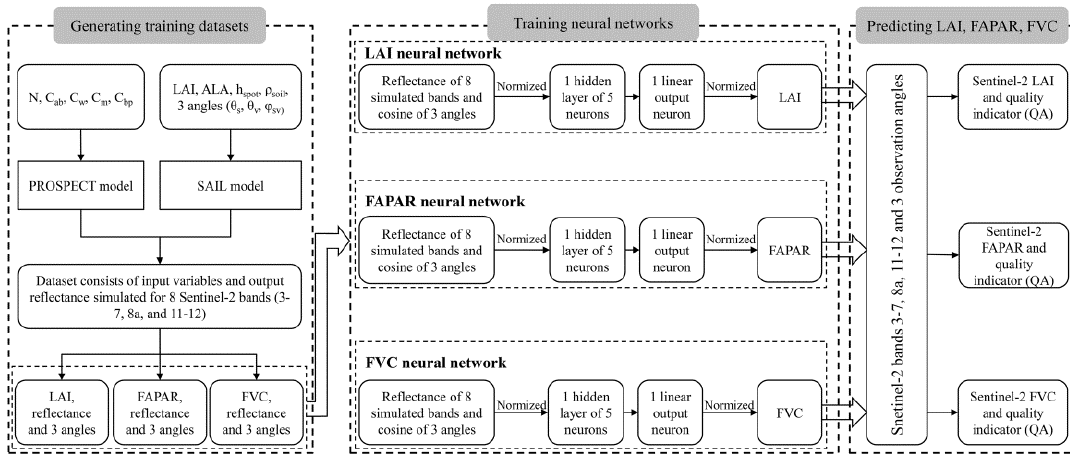
Figure 3. The framework of the Leaf Area Index (LAI), Fraction of Absorbed Photosynthetically Active Radiation (FAPAR), and Fractional Vegetation Cover (FVC) retrieval algorithm for Sentinel-2 imagery. The “N”, “C ab ”, “C w ”, “C m ”, “C bp ” in the PROSPECT model and “LAI”, “ALA”, “h spot ”, “ρ soil ”, “θ s ”, “θ v ”, “φ sv ” in the Scattering from Arbitrarily Inclined Leaves (SAIL) model denote mesophyll structure index, chlorophyll content (μg/cm 2 ), dry matter content (g/cm 2 ), water content (g/cm 2 ), brown pigment content for leaf and leaf area index (m 2 /m 2 ), average leaf angle (°), hot spot parameter, sol reflectance, solar zenith angle (°), view zenith angle (°), relative azimuth angle between solar and view (°), respectively.